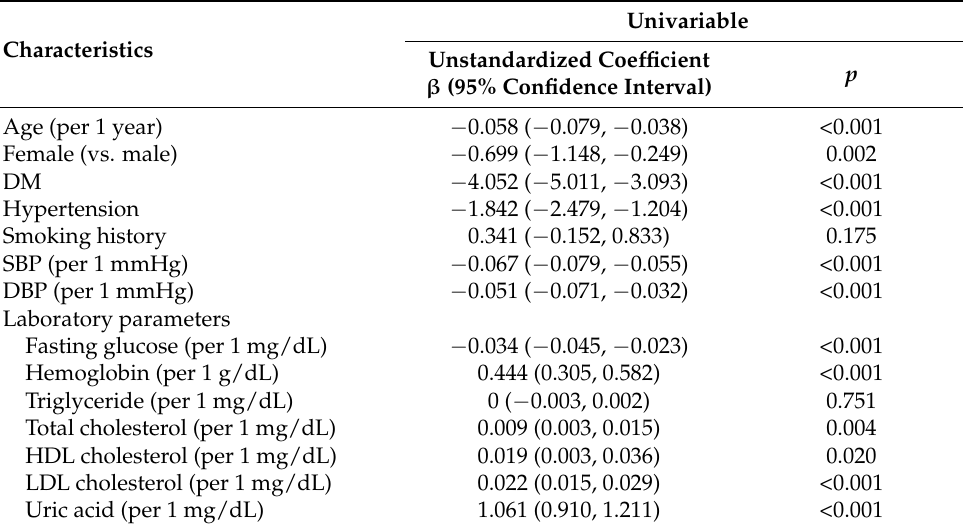
Table 5. Determinants for (cid:52) eGFR using univariable linear regression analysis in follow-up partici- pants ( n =